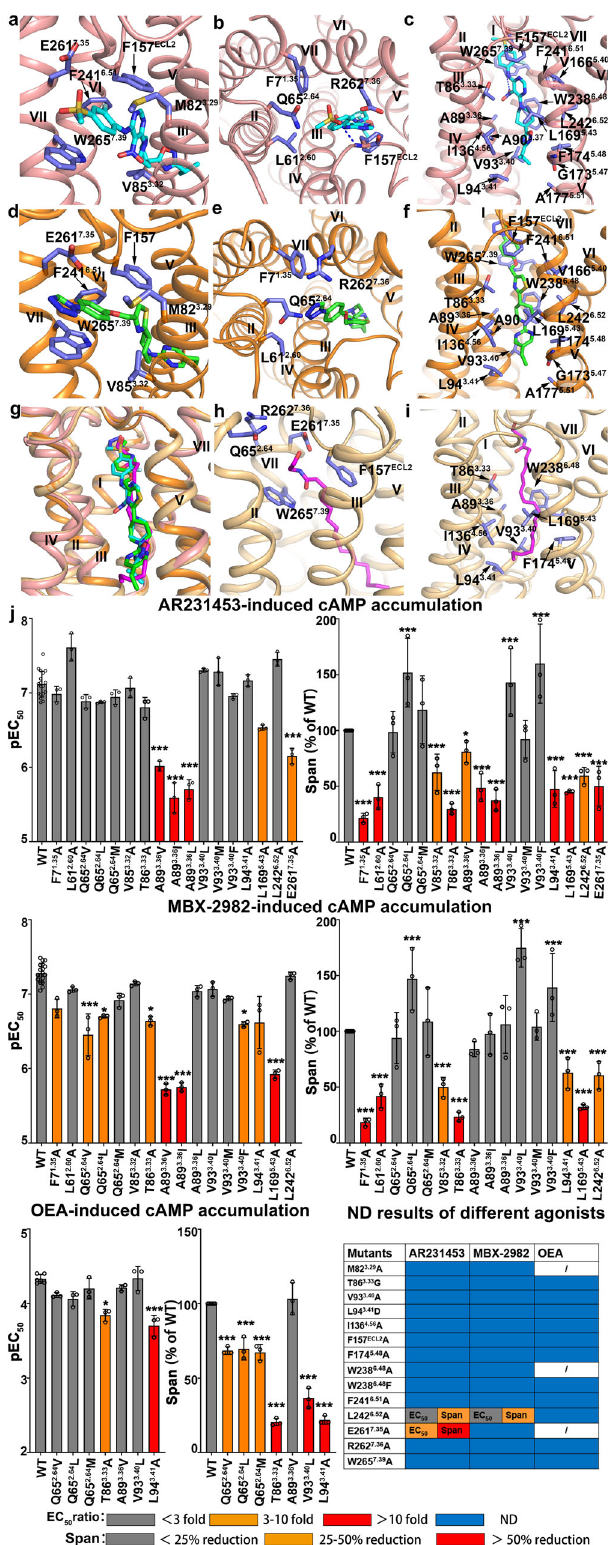
Fig. 3 | Agonist interactions in GPR119 ligand-binding pocket. a – f Ligand- receptor interactions in stacking gate ( a , d ) between GPR119 and AR231453 ( a ) or MBX- 2982 ( d ), in extracellular cavity ( b, e ) between GPR119 and AR231453 ( b ) or MBX-2982 ( e ), and in activation cavity ( c, f ) between GPR119 and AR231453 ( c ) or MBX-2982 ( f ). g Superimposition of OEA with AR231453 and MBX-2982 in GPR119 ligand-binding pocket. h , i Ligand-receptor interactions in extracellular cavity and stacking gate between GPR119 and OEA of the docking model ( h ) and in activation cavity( i ). j cAMPaccumulationofGPR119inducedbyagonistAR231453,MBX-2982 and OEA. (EC50 ratio = EC50 of mutant/EC50 of wild type) and maximal